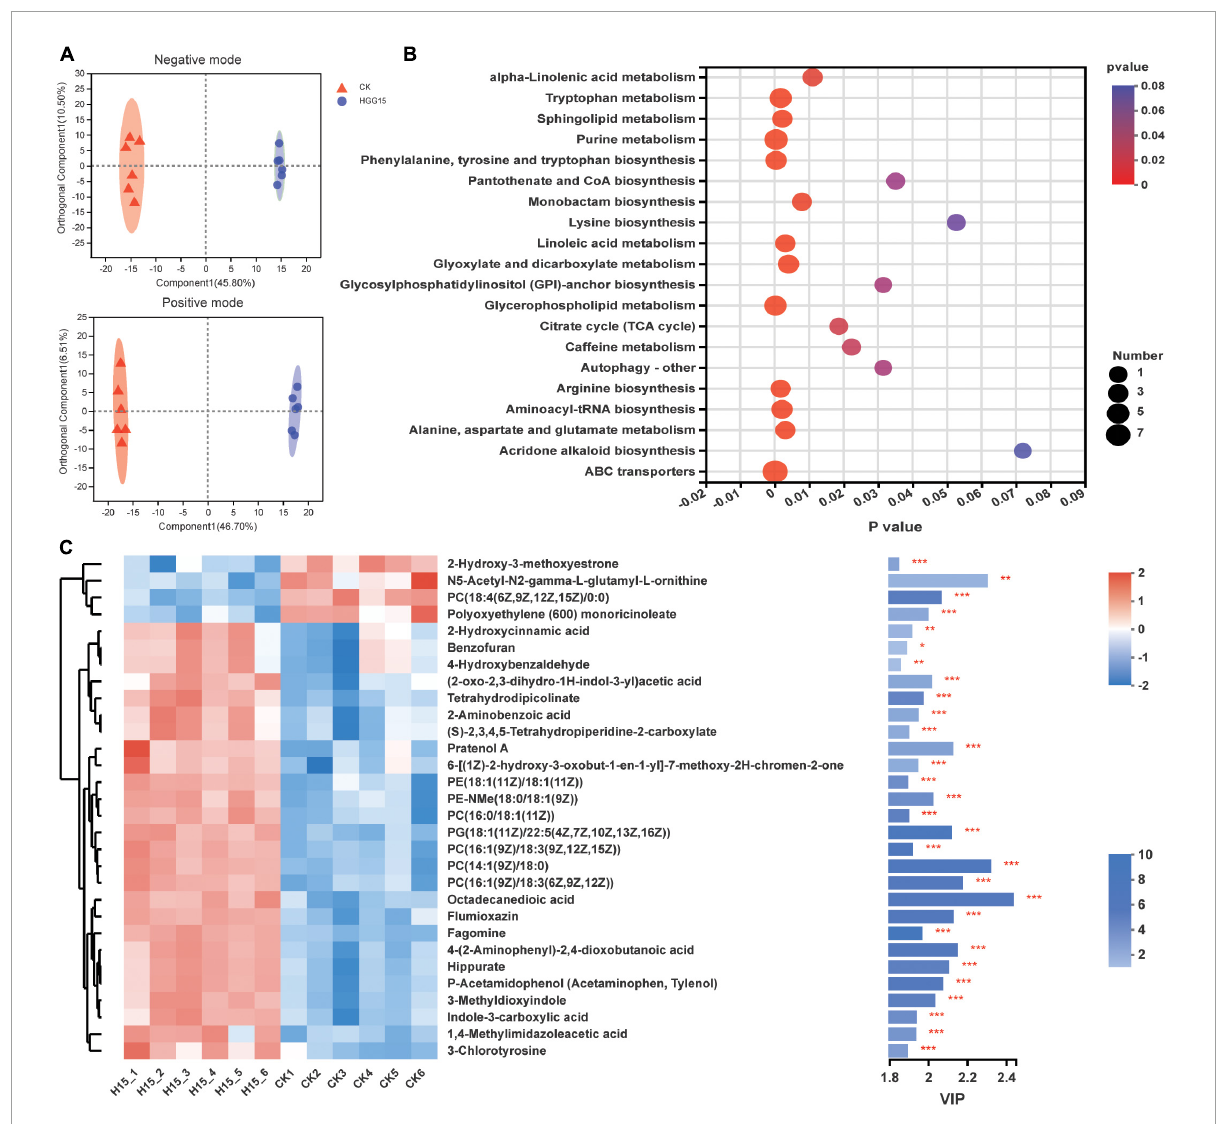
FIGURE7 Effects of K. aerogenes HGG15 strain on metabolites of mulberry root. (A) Orthogonal partial least squares discriminant analysis of mulberry metabolites using positive and negative modes. (B) KEGG pathway enrichment analysis of differentially accumulated metabolites. The x -axis and y -axis represented the P -value of enrichment and enrichment pathway, respectively. The size of node represented the amount of metabolite enriched in the pathway. (C) Variable importance in projection scores of top 30 different metabolites between control and inoculated group. Left, heatmap of the differentially accumulated metabolites. The correlation of color and value was shown in the upper right bar. Right, bar chart of differentially accumulated metabolites. The length of bar indicated the contribution degree of this metabolite. The color of bar showed the difference degree of metabolite and the darker color represented the larger value of − log 10 ( P -value) as shown in lower right bar. *** P < 0.001, ** P < 0.01, * P <